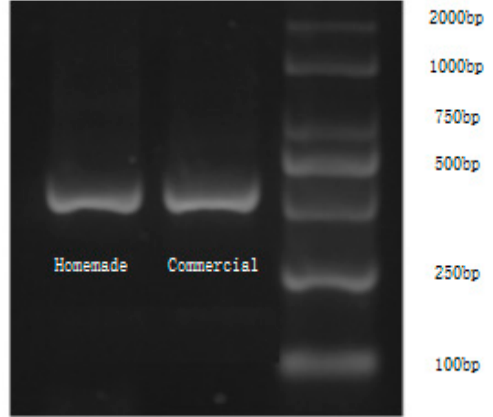
Figure 6. Results of DNA amplification of Escherichia coli using commercial PCR (LifeECO) and Homemade PCR with upgraded temperature cycle. The image shows the relative intensity of targeted genes amplified by the commercial PCR and homemade PCR and analyzed using ImageJ software.